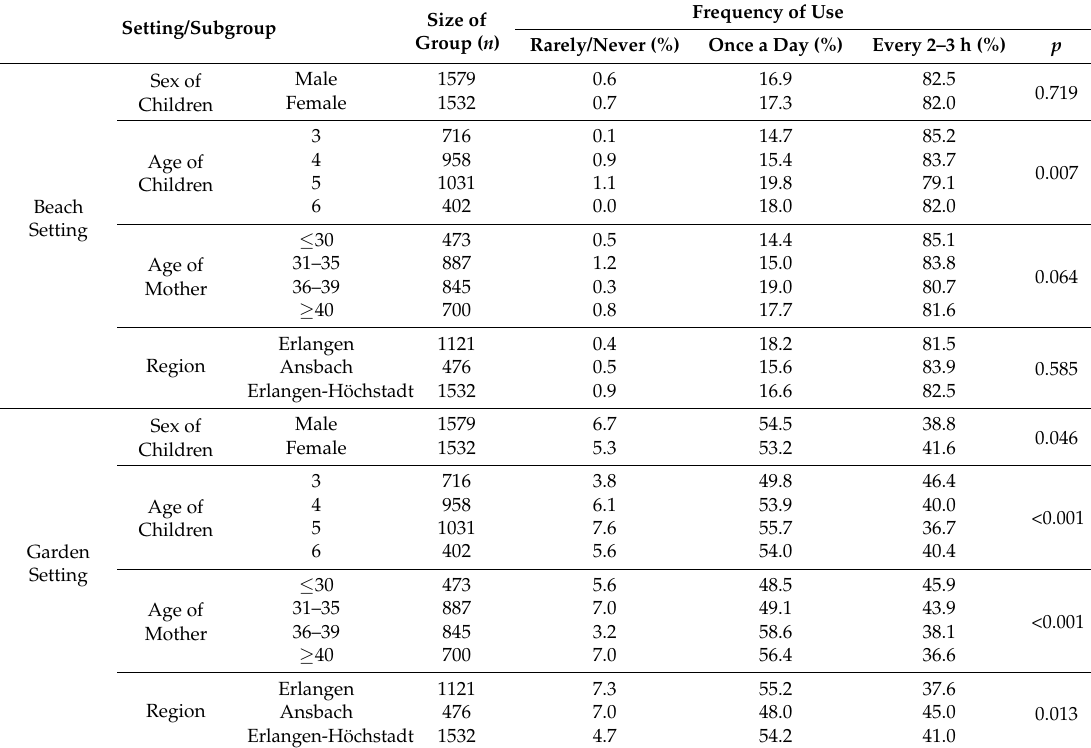
Table 4. Frequency of using sunscreens in two outdoor settings (beach—upper part and garden—lower part) based on answers of 3129 parents of three- to six-year old children in the Erlking-II-study in three Bavarian districts in Southern Germany.